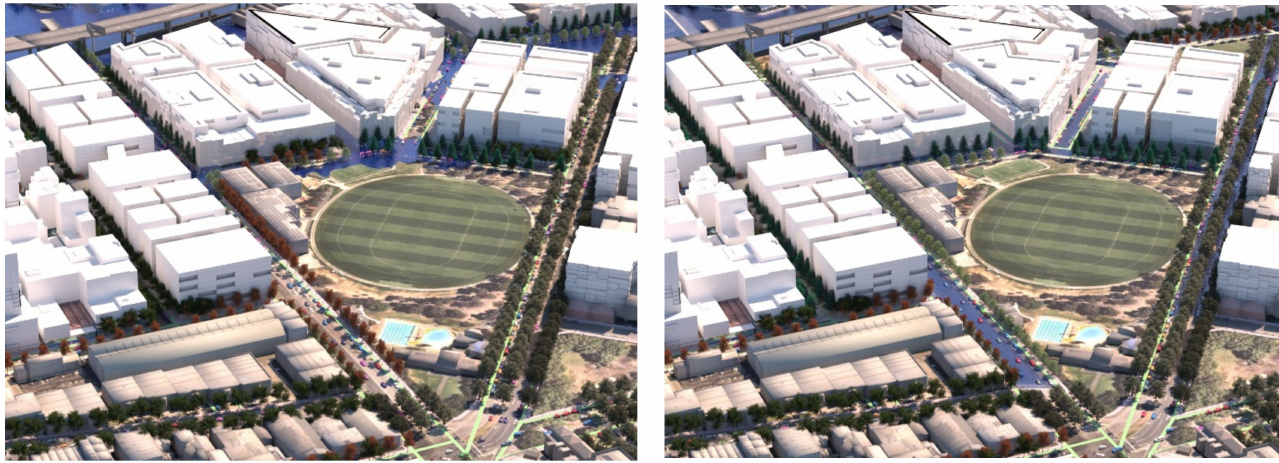
Figure 14. Detail: LEFT Flood scenario (1) and RIGHT Flood scenario (2) showing species change responding to flood extent. Image by authors using multi-criteria street tree design decision support modelling approach in Autodesk™ 3ds